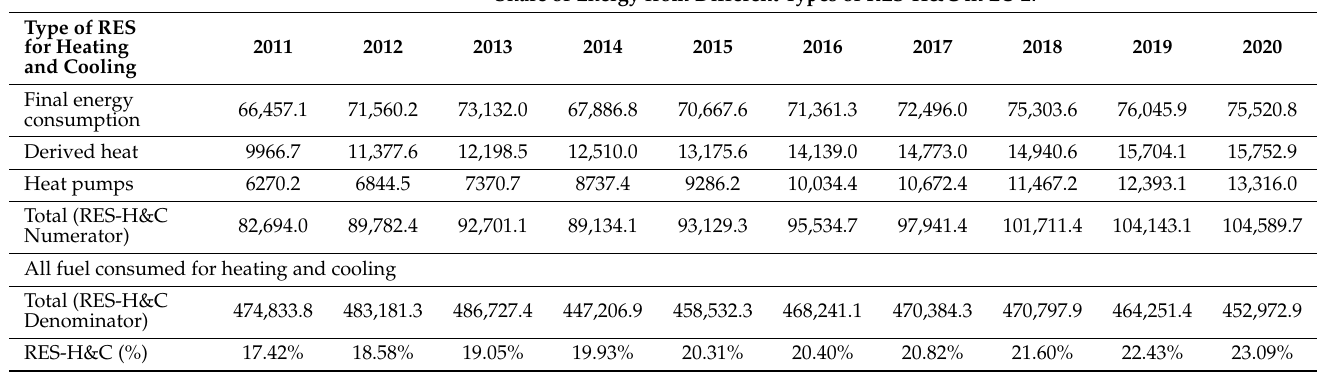
Table 5. Share of energy from different types of renewable sources for heating and cooling in EU 27 in the last 10